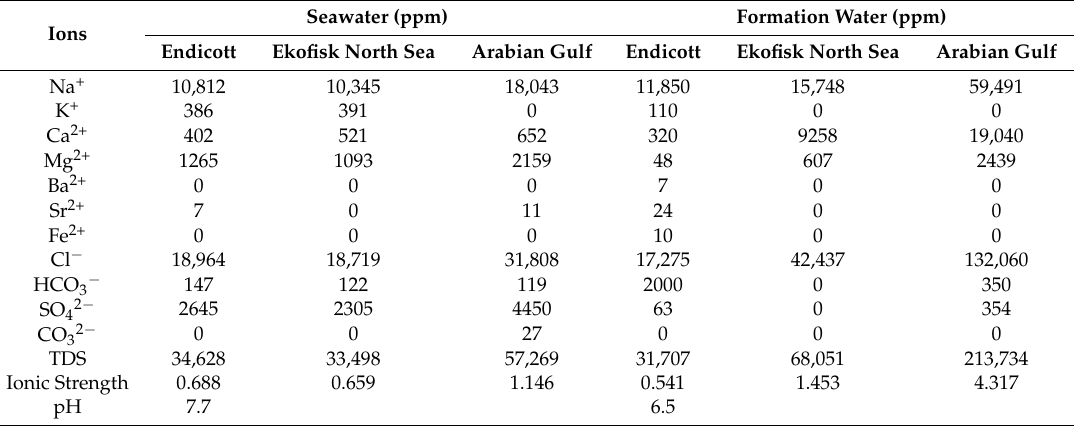
Table 1. Different common formation water and seawater contents applied during brine-dependent recovery process (adapted from